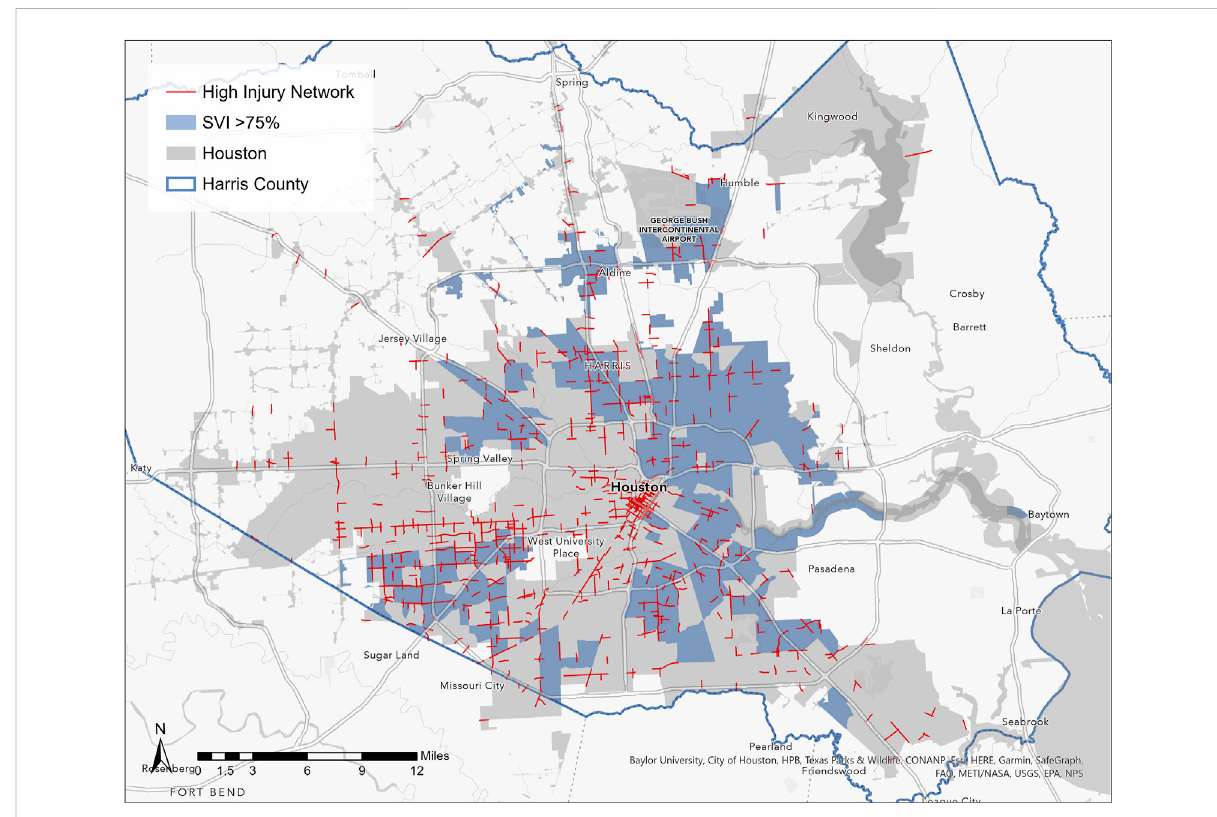
FIGURE 1 HoustonHighInjuryNetwork,whichisthe6%ofstreetsthataccountfor60%oftraf fi cdeathsandseriousinjuries,2014 – 2018(CityofHouston,